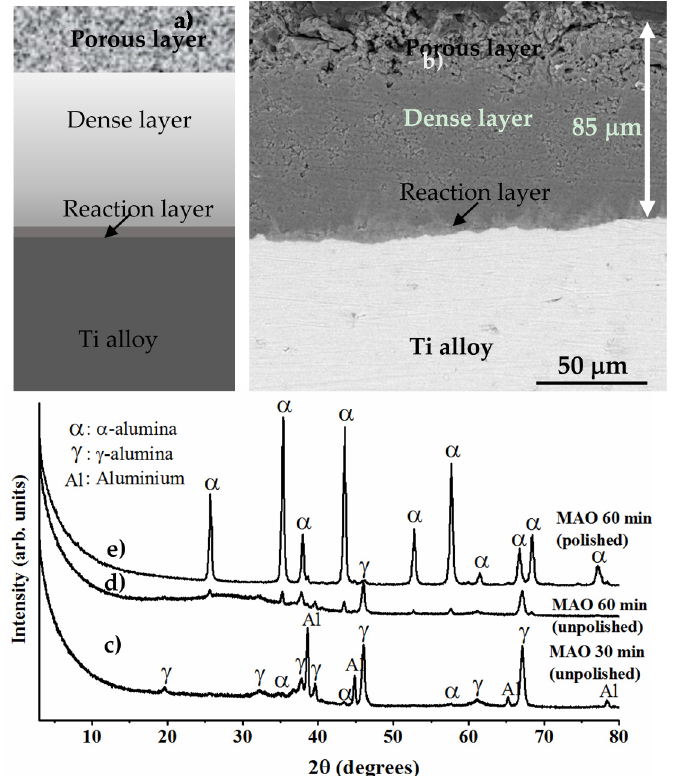
Figure 7. Schematic view of section of designed alumina/Ti alloy model ( a ); corresponding BSE image of alumina layer on the Ti alloy ( b ); and TF-XRDs of CS-Al layer after MAO for 30 min ( c ); 60 min ( d ); and after polishing ( e ). Reproduced from [101] with permission from Elsevier.